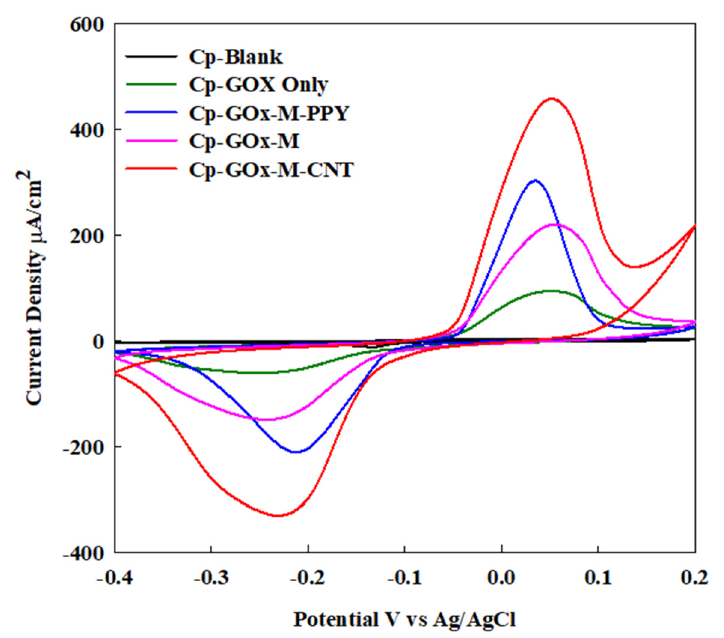
Figure 4. Voltammograms of hydrophobic bioanode electrodes under 0.1 M PBS, pH 7, 37 °C, and N 2 saturation. N 2 saturation.